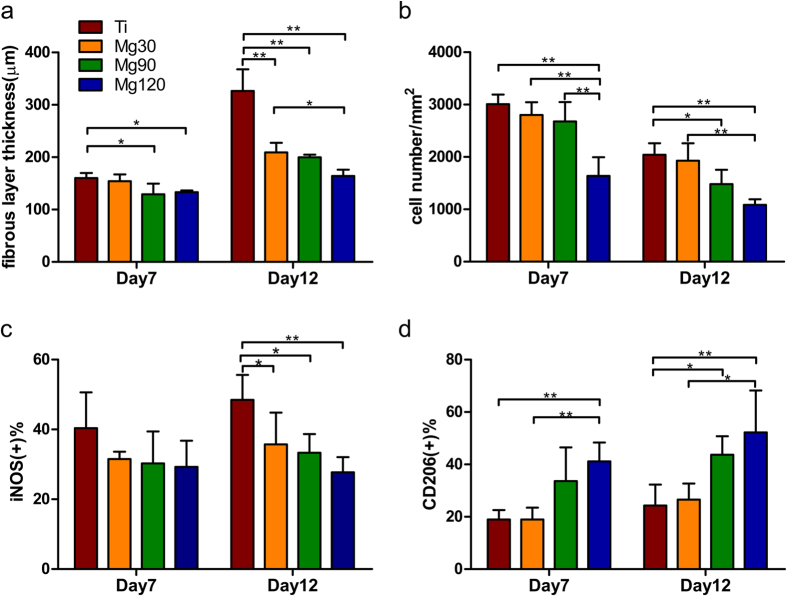
Quantitative analysis of (a) fibrous layerthickness, (b) number of infiltrated cells, (c) iNOS-positive cells (M1) and (d) CD206-positive cells (M2). (Statistically significant difference: *p < 0.05; **p < 0.01; triplicate).